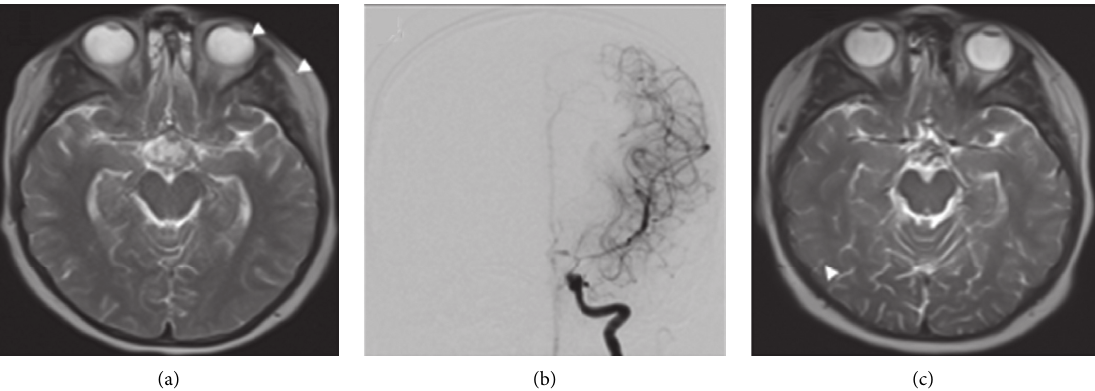
Figure 1: (a) Postoperative axial T2 sequence magnetic resonance of the brain evidencing reduced flow void diameters of the middle and anterior cerebral arteries surrounding the surgical resection cavity (postoperative day 13); (b) anteroposterior view digital subtraction angiography of a left ICA contrast injection evidencing severe vasospasm of the terminal portion of the ICA (arrow), proximal anterior, and middle cerebral artery (postoperative day 17); (c) postoperative axial T2 sequence magnetic resonance of the brain demonstrating improved flow void caliber of the terminal: internal carotid, middle, and anterior cerebral arteries (3 months postoperatively).